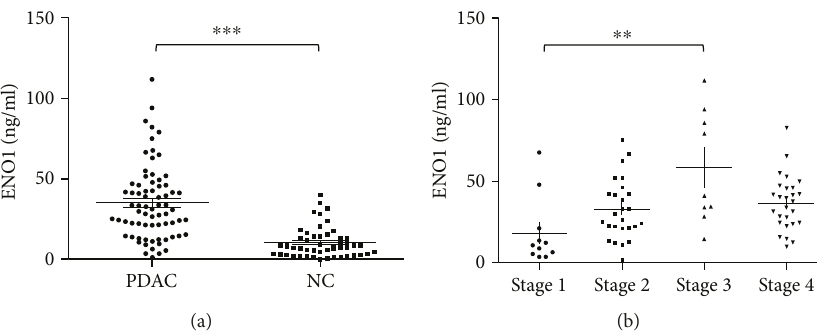
Figure 2: The level of ENO1 in plasma of PDAC patients, corresponding to clinical stages and prognosis. (a) Scatter plot demonstrated the ENO1 concentrations in plasma of PDAC patients ( n = 73 ) and normal controls ( n = 50 ). ENO1 was detected with ampli fi ed luminescent proximity homogeneous assay (AlphaLISA) method. (b) Scatter plot represented the ENO1 concentrations in plasma of PDAC patients with di ff erent clinical stages (stage I: n = 11 ; stage II: n = 19 ; stage III: n = 27 ; stage IV: n = 16 ). ∗∗ P < 0 01 , ∗∗∗ P < 0 001 .